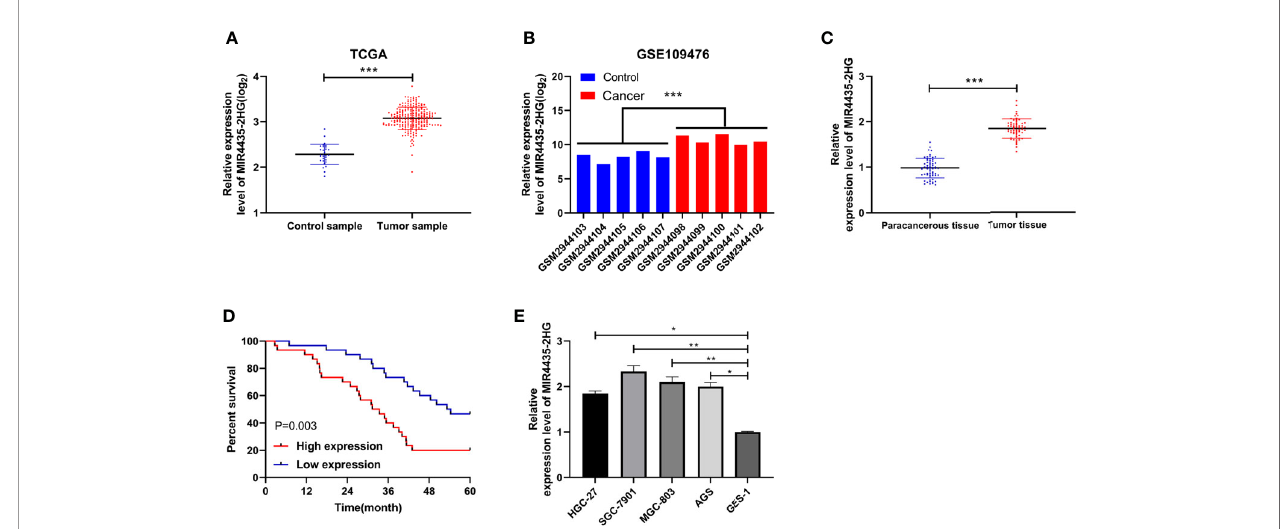
FIGURE 1 | Correlation of MIR4435-2HG in gastric carcinoma with the survival. (A) The Cancer Genome Atlas (TCGA) found that MIR4435-2HG elevated in gastric carcinoma. (B) MIR4435-2HG in GSE109476 chip of Gene Expression Omnibus (GEO). (C) qRT-PCR was applied to test MIR4435-2HG in tumor tissues of patients with gastric carcinoma. (D) Kaplan – Meier (K-M) survival analysis of 5-year survival of patients with high and low MIR4435-2HG. (E) qRT-PCR detection of MIR4435- 2HG in gastric carcinoma cell lines. * indicates p < 0.05; ** indicates p < 0.01; *** indicates p < 0.001.